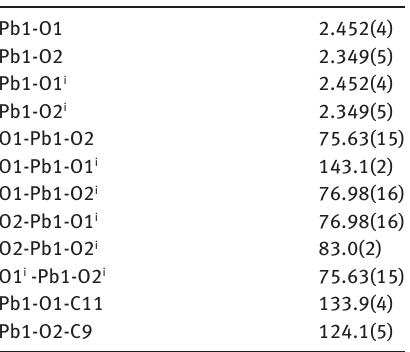
Table 1 Selected bond lengths (Å) and angles ( ° ) for the title